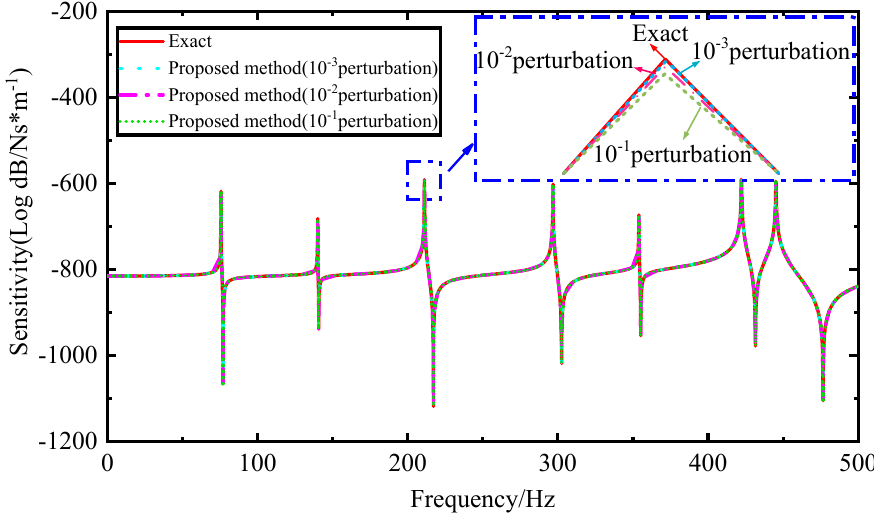
Figure 4. Sensitivity of FRFs to elastic modulus.